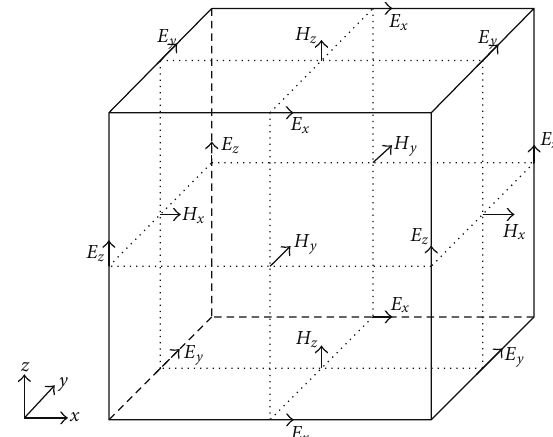
Figure 1: Position of E- and H-fields in the FDTD cell.